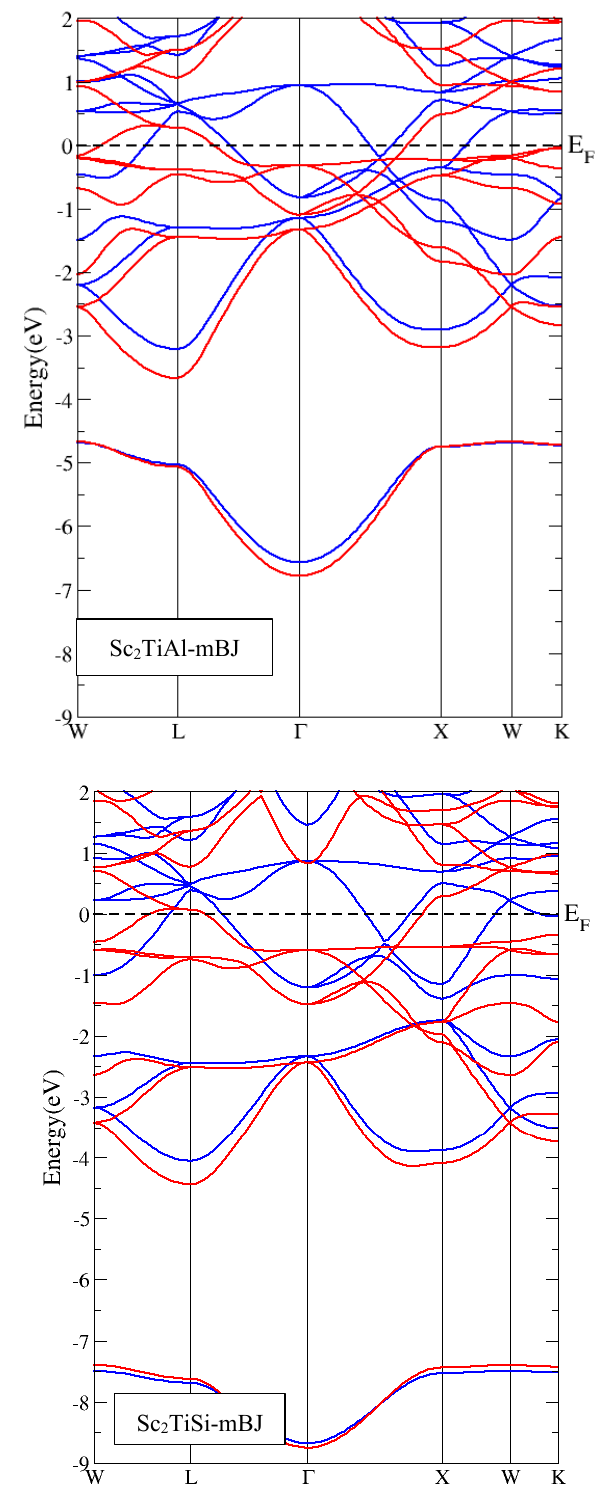
Figure 4. Calculated band structure for regular Sc 2 TiAl and Sc 2 TiSi using GGA and mBJ (blue lines for spin-up, red lines for spin-down).